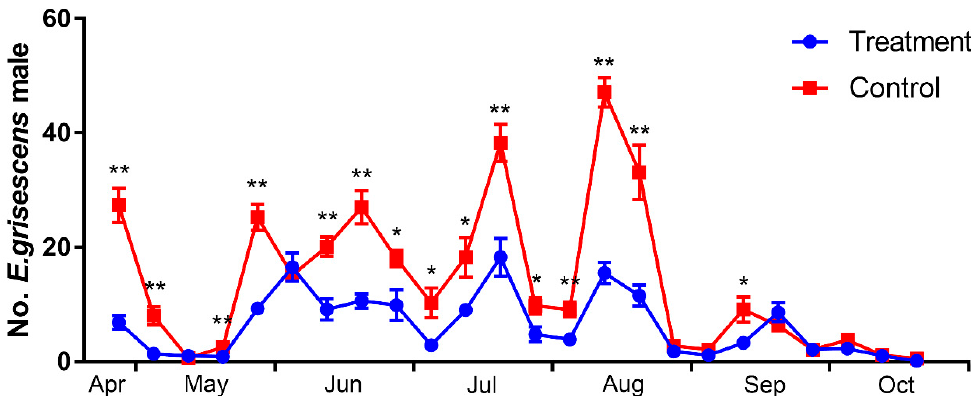
Figure 9. Assessment of larger plot sex pheromone mass trapping trials on population density of Ectropis grisescens adult male (25 April–31 October 2017). Difference between mass trapping and control plot was analyzed by Student’s t ‐ test and expressed as one and two asterisks indicating significant statistical differences between the two species at p < 0.05 and p < 0.01, respectively.